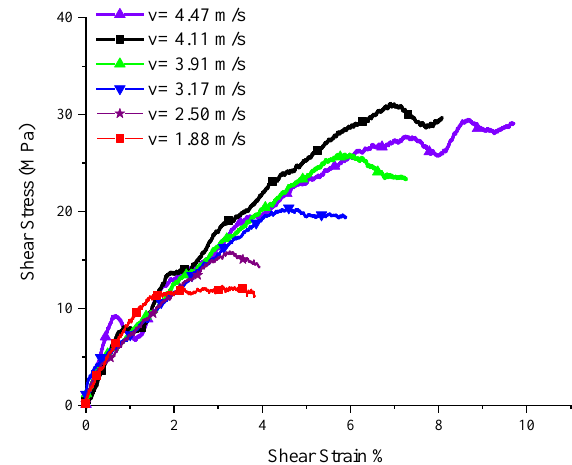
Figure 6. Normal stress–strain of 15° SCSs at different impact speeds.